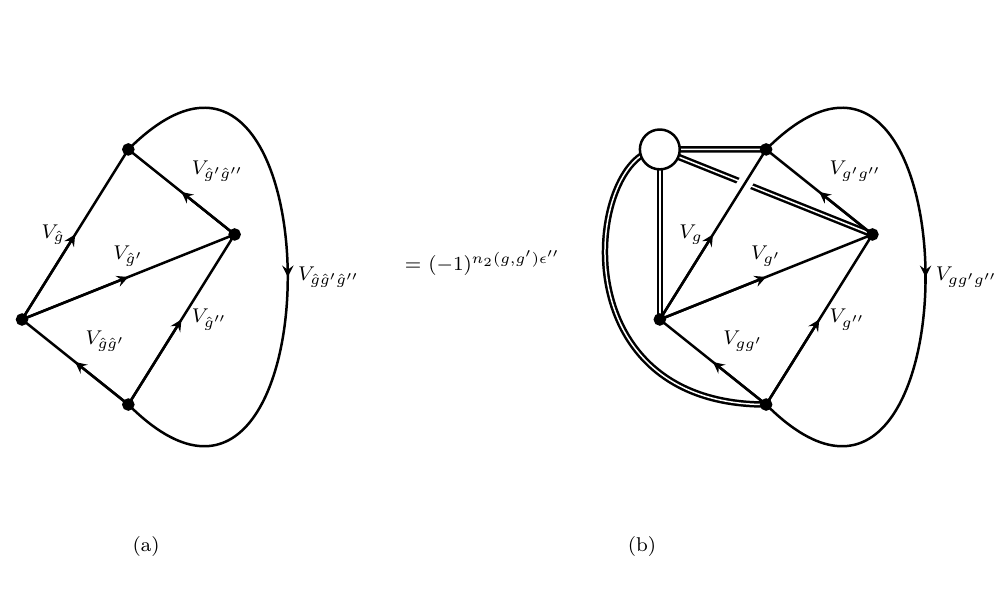
Figure 18 . Gauge-(cid:12)xing: a graphical representation of the partial gauge-(cid:12)xing procedure used in computing the ^ G group cocycle. Left: a choice of gauge is the same as a choice of basis vector in the space of junctions between line defects in the full ^ G category. Right: we identify V and identify V with the corresponding elements I or (cid:5) of the center. We then express a general (1 ;(cid:15) ) junction canonically in terms of a choice of junction between line defects labelled by G elements. The double lines denote the center elements. The empty circle represents any choice of how to connect the center lines in a planar way.